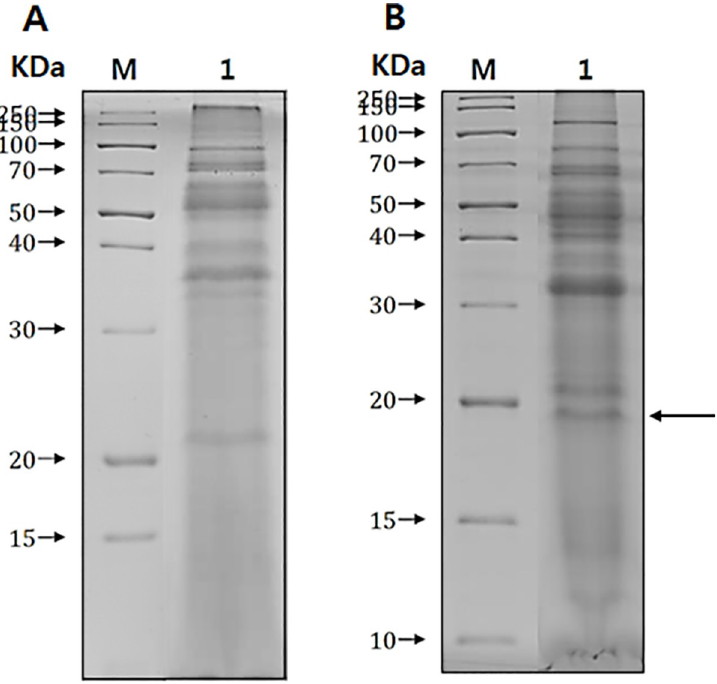
Fig 1. Secretory proteins of A . castellanii . Secretory proteins between non-pathogenic Acanthamoeba (ATCC 30011) (A) and pathogenic Acanthamoeba (ATCC 30868) (B) were compared by SDS-PAGE. M; protein size marker, lane 1; conditioned media of Acanthamoeba . An arrow indicates a specific protein band of pathogenic Acanthamoeba origin.